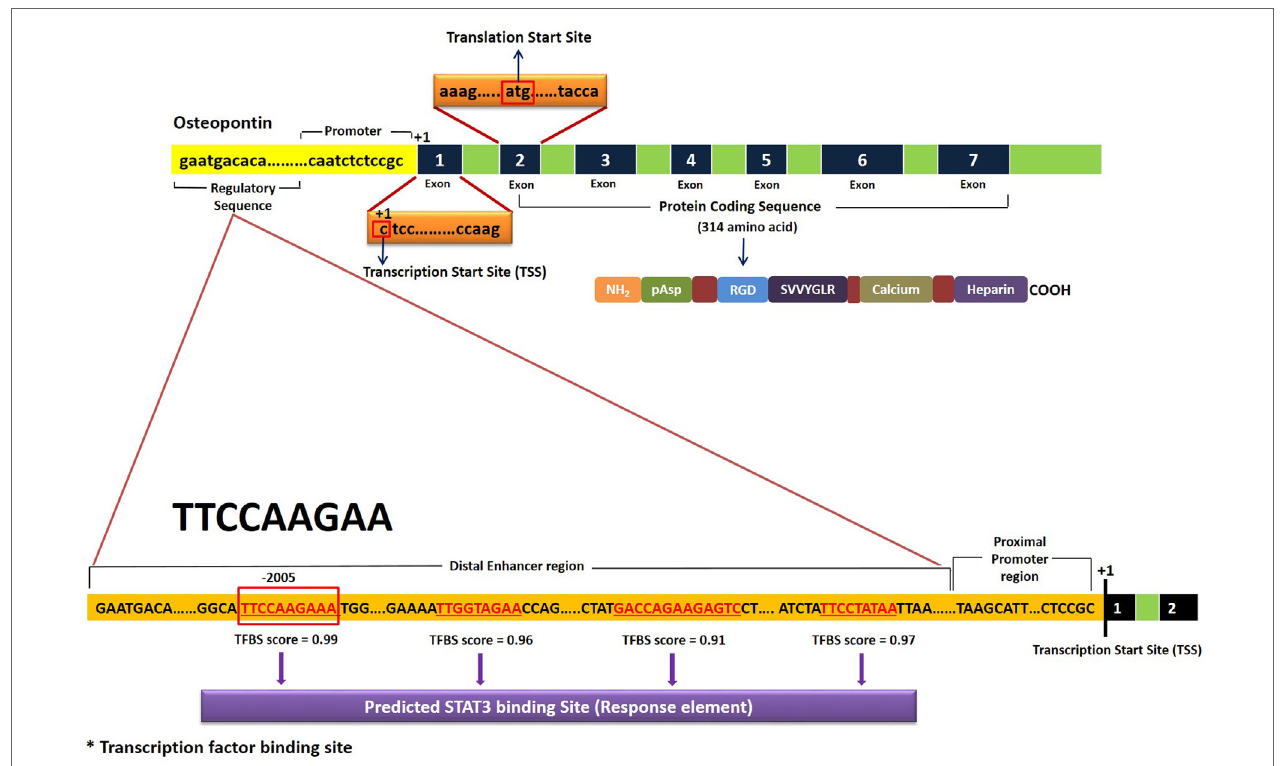
FigUre 5 | Schematic representation of STAT3 transcription factor binding site (TFBS) in the human OPN gene. Results were obtained using STAT Finder Bioinformatics Tool (33,